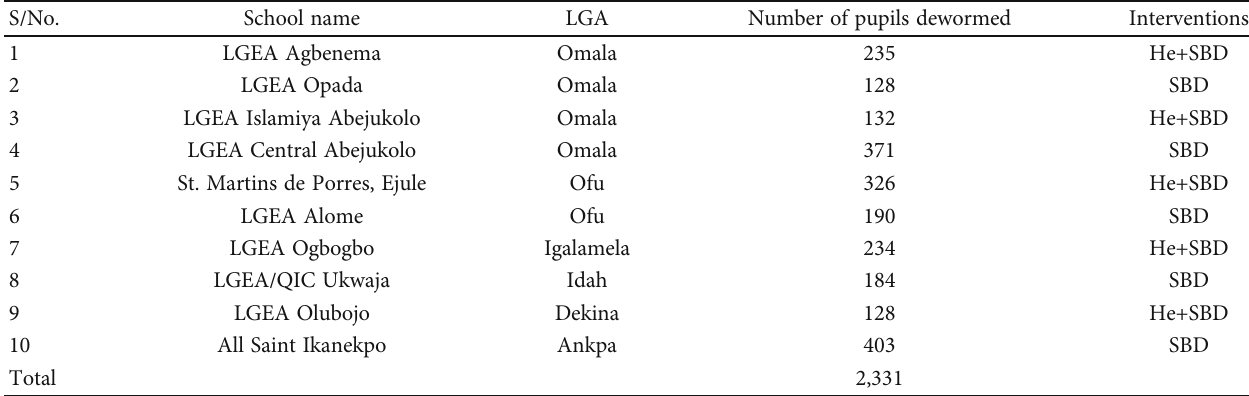
Figure 3: Flow chart of intervention procedure. Note: during each follow-up study, stool specimens were collected and examined. At the intervention schools, health education rehearsal was carried out. Table 2: Deworming of primary school children in Kogi East.